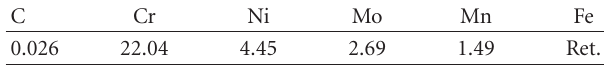
Table 1: Chemical composition of 2205 DSS